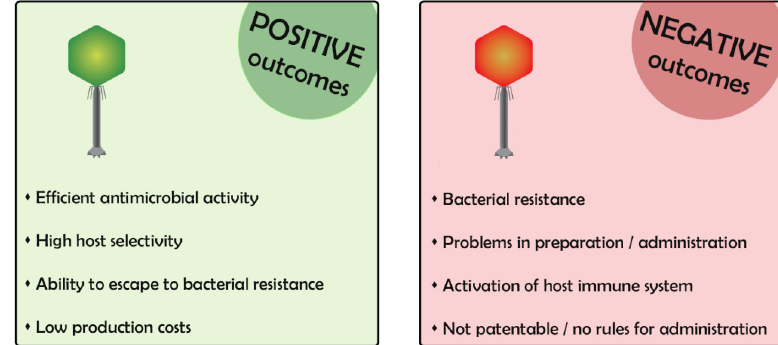
Figure 1. Positive and negative outcomes of phages.